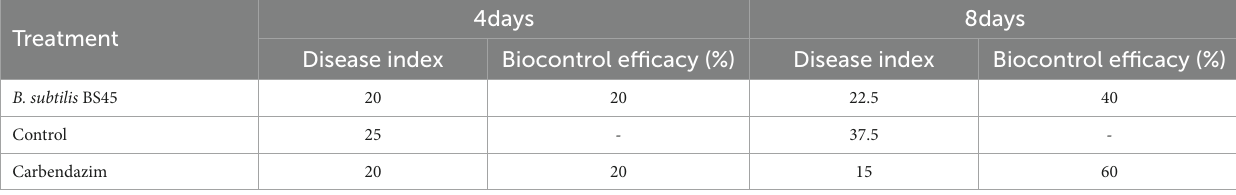
TABLE 6 Effects of Bacillus subtilis BS45 against Fusarium root rot in a greenhouse